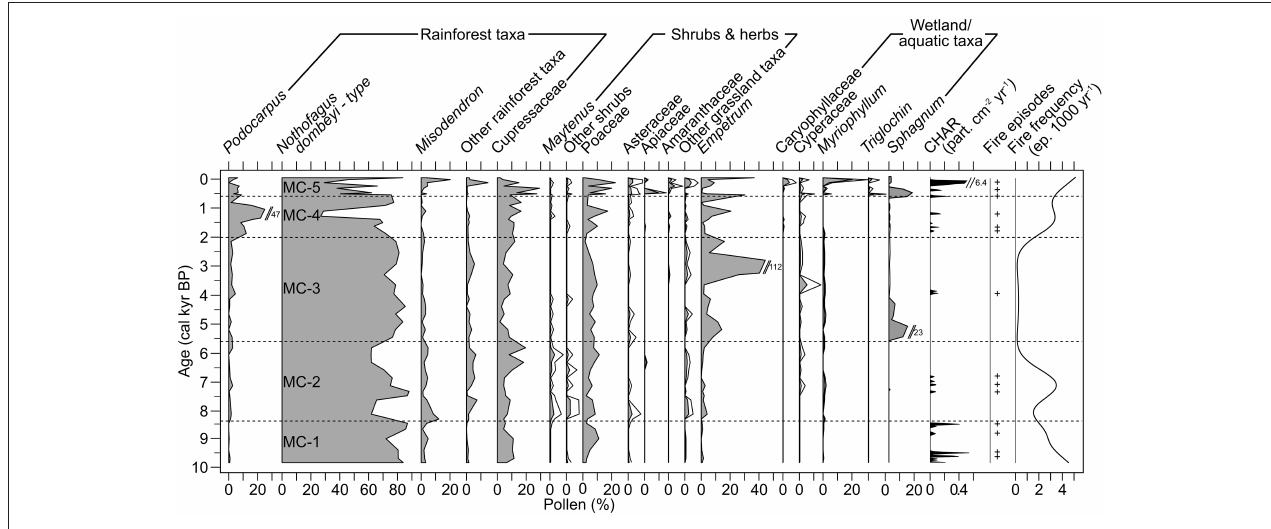
FIGURE 3 | Pollen percentages of selected taxa and macroscopic charcoal data from M. Casanova. Exaggeration curves depict 3*taxa